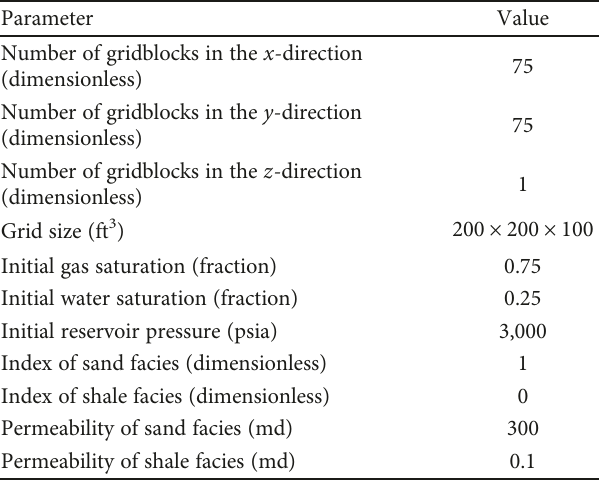
Table 2: Reservoir properties of the channelized gas